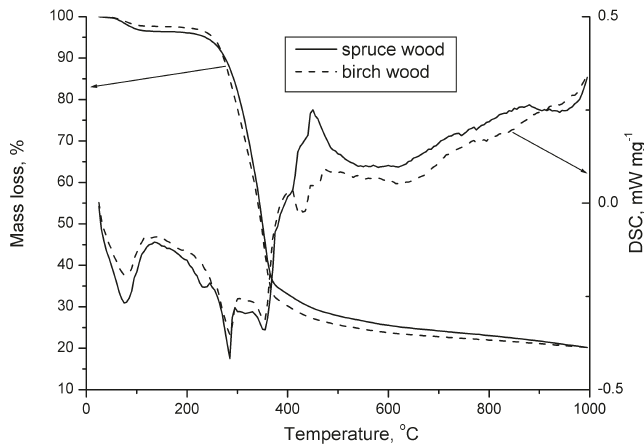
Figure 1. Thermogram of the pyrolysis of spruce and birch with a heating rate 5°C min -1 .